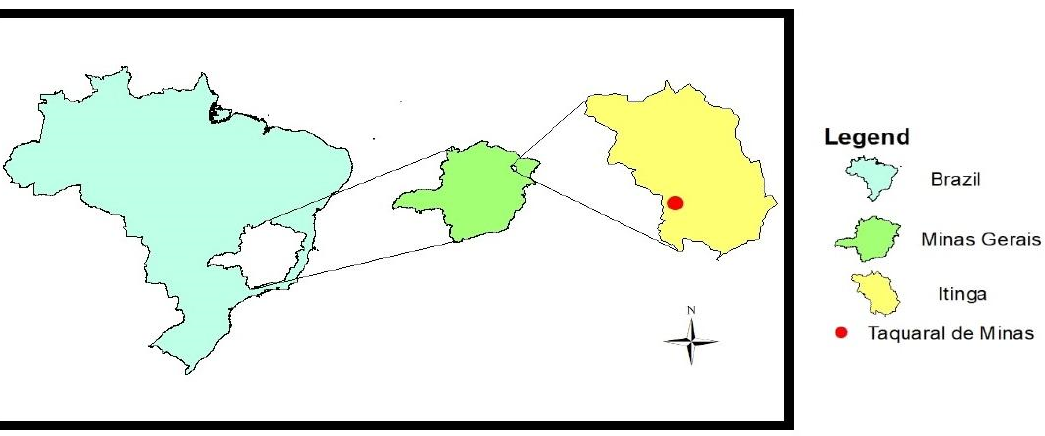
Figure 1. Location of biological and environmental samples (district of Taquaral de Minas, municipality of Itinga, state of Minas Gerais, Brazil). Geographic coordinates 41°51 ′ 45 ″ W. 16°42 ′ 45 ″ S.